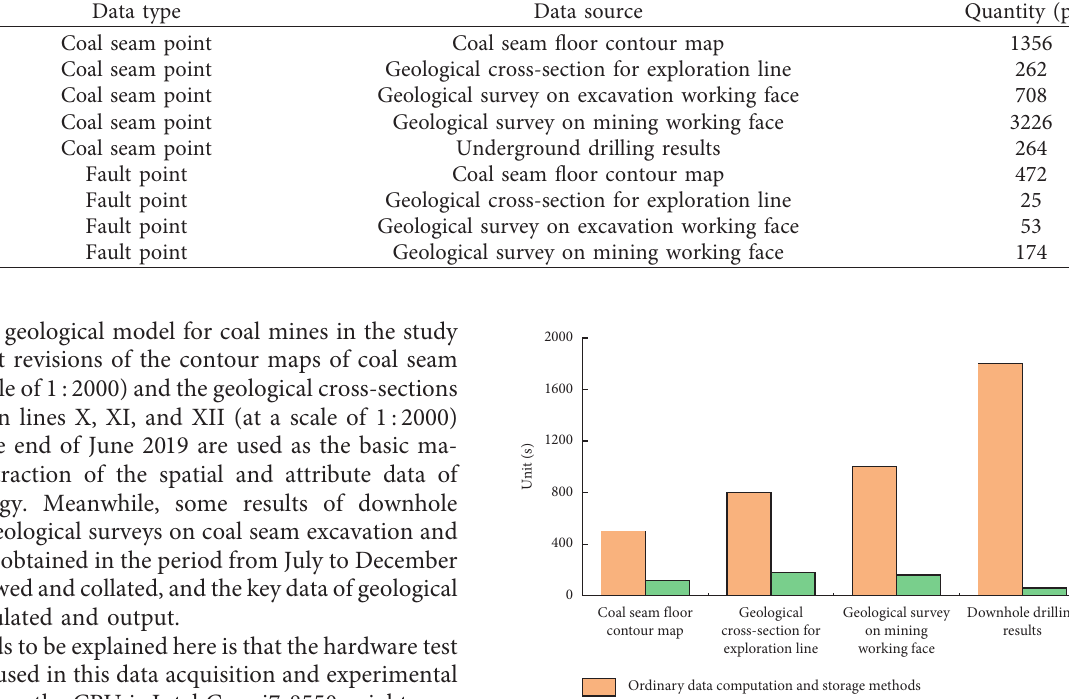
Table 3: Extraction of basic geological data in the northeastern panel of a coal mine in Huainan mining area.